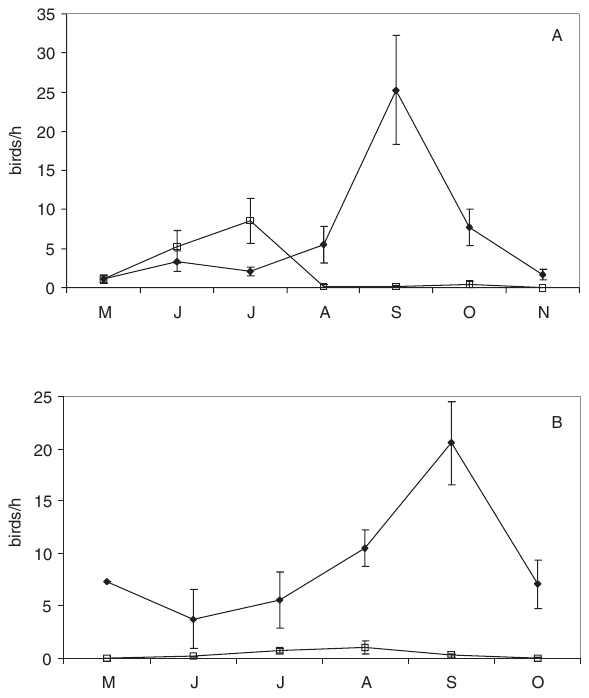
F IG . 5. – Monthly distribution (mean ± SE) of the migratory passage (birds/h) at Estaca de Bares. A, 1999; B, 2000. Open symbols = eastward migration; filled symbols = westward migration.